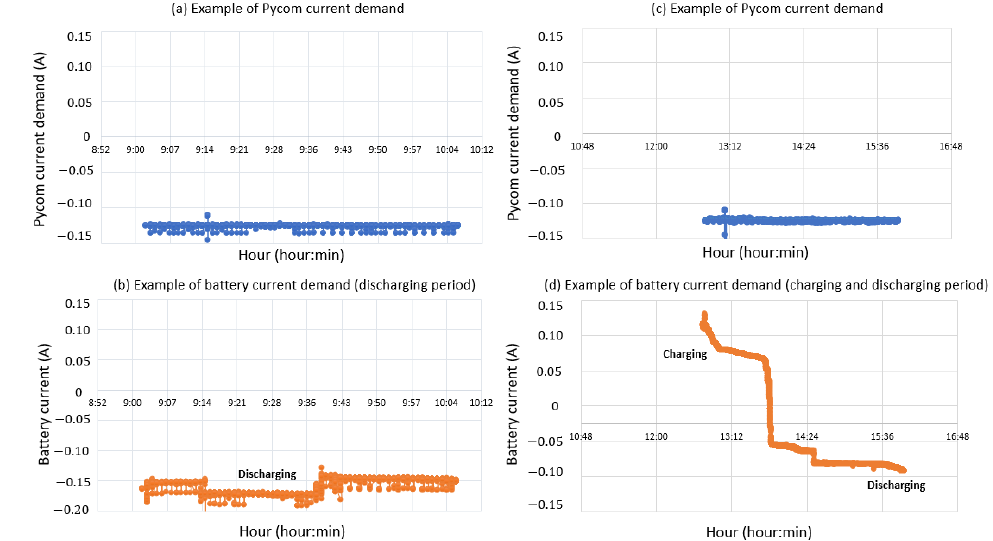
Figure 13. Examples of Pycom demand consumption and battery power monitoring: ( a , b ) discharging battery period; ( c , d ) charging and discharging battery